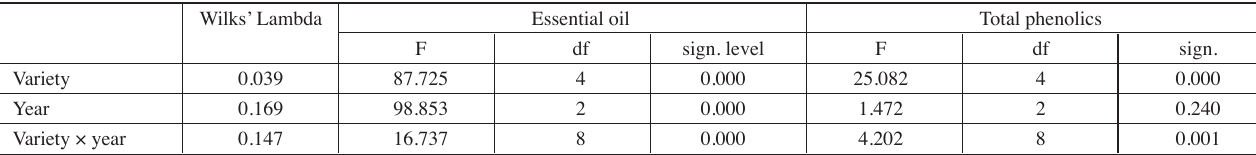
Tab. 3: Results of the multivariate test for EO yield and total phenolics content data